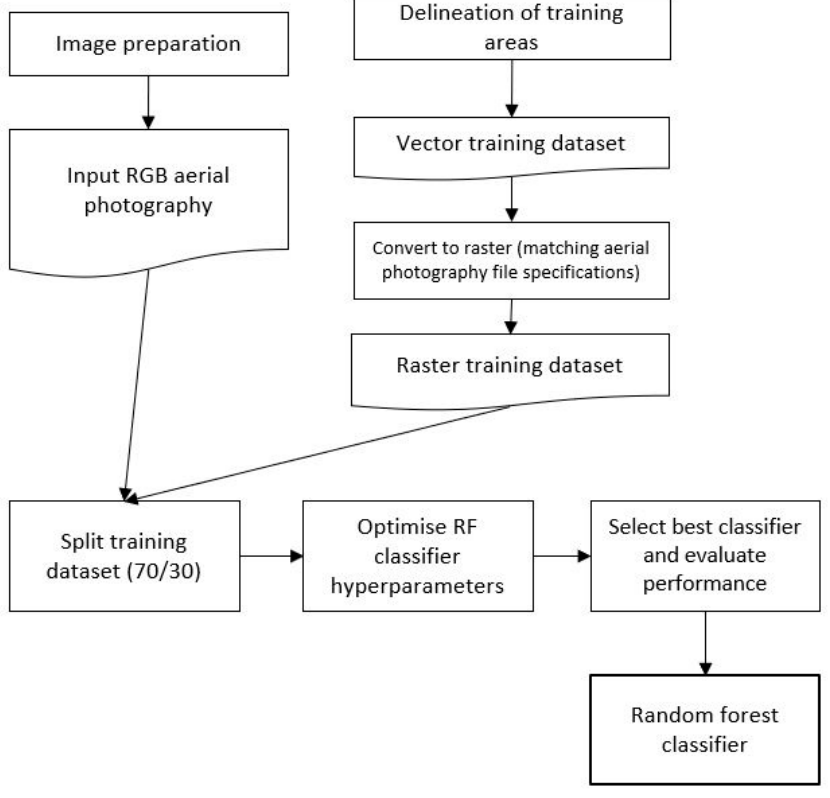
Figure 3. Overview of the random forest classifier training workflow. Table 4. Summary of data used to train and validate the random forest classifiers for alligator weed detection in Victoria,